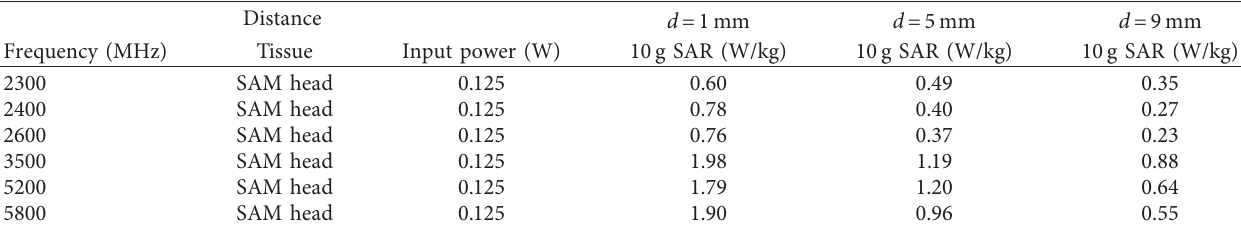
Table 6: Maximum SAR results at each frequency for each distance of antenna next to